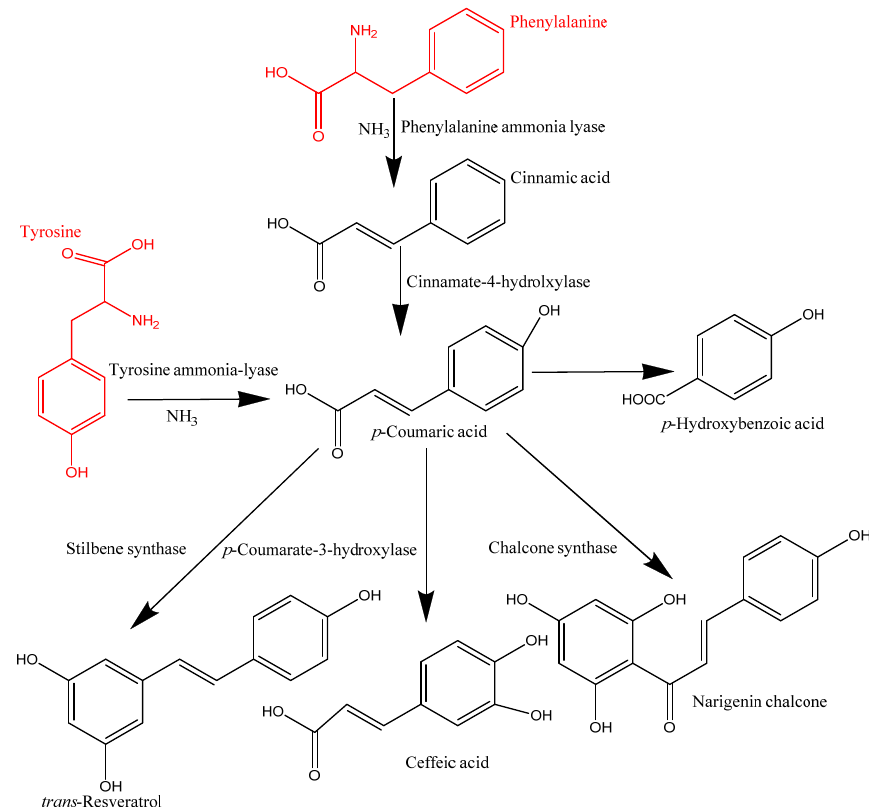
Figure 2. Synthesis of phenolic compounds .